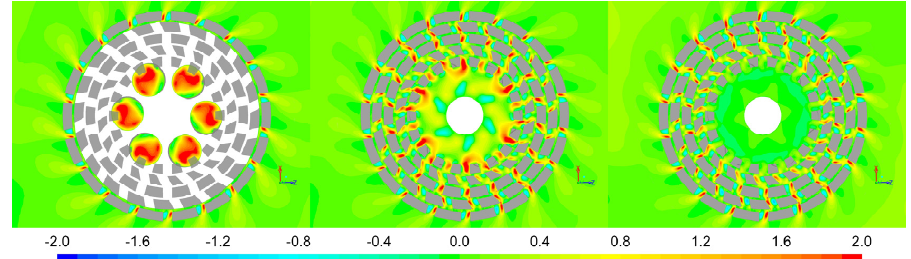
Figure 5. Radial velocity at 6000 rpm for the same planes as in Figure 4. Color scale is in m/s.